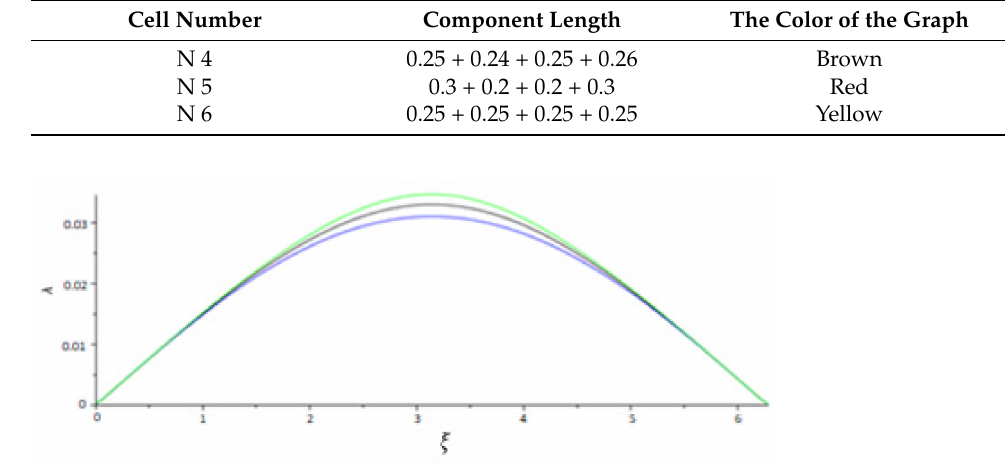
Figure 4. Small perturbations of a monodisperse crystal with a constant concentration of components of the form 0.5 + 0.5 + 0 + 0: N1 crystal of the kind 0.4 + 0.4 + 0.1 + 0.1, color = black; N2 crystal of the